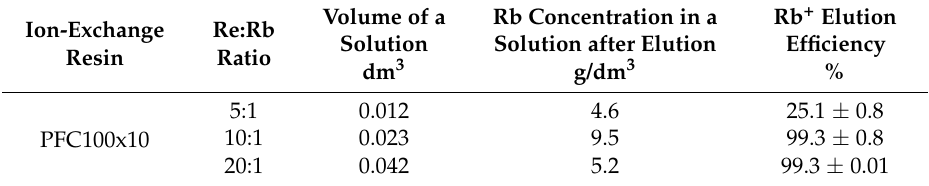
Table 7. Effect of the rhenium-to-rubidium ratio on the rubidium ion elution